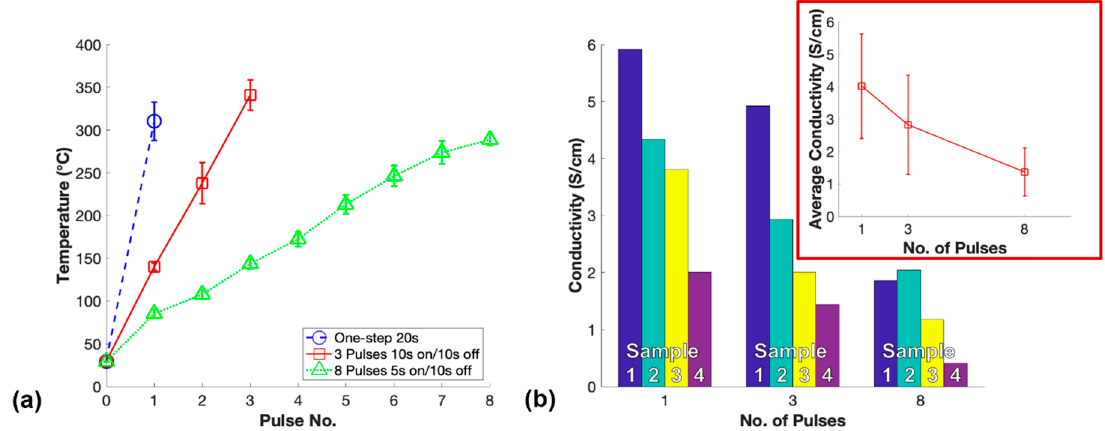
Figure 7. Pulse study—( a ) Average temperature measurements between pulses of 50% microwave power used to cure 1 wt.% PDMS/CNT and ( b ) conductivity of each set of samples for the varying number of pulses used to fabricate 1 wt.% m-PDMS/CNT.